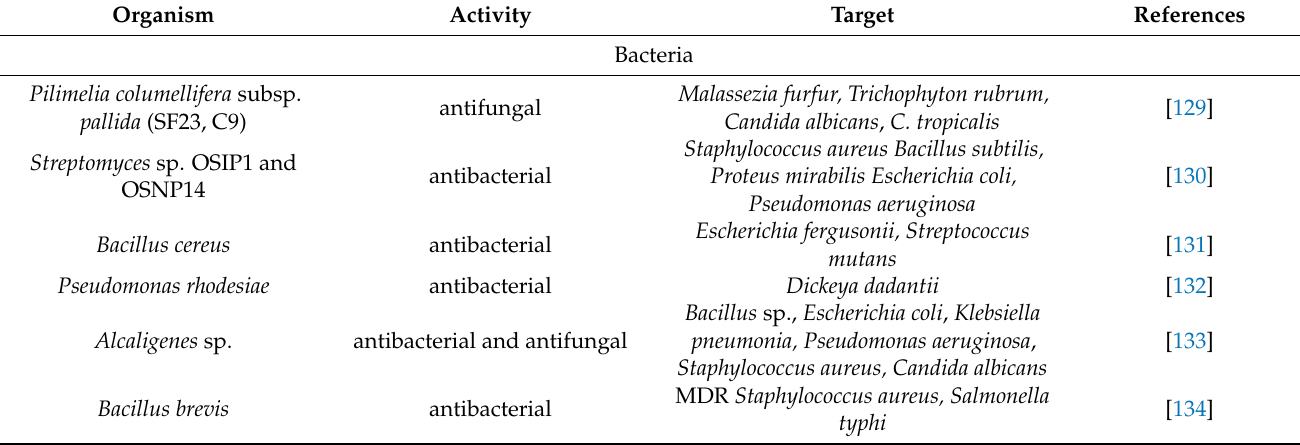
Table 3. Selected examples of biogenic AgNPs and their antimicrobial activity Key: MDR; multidrug-resistant.